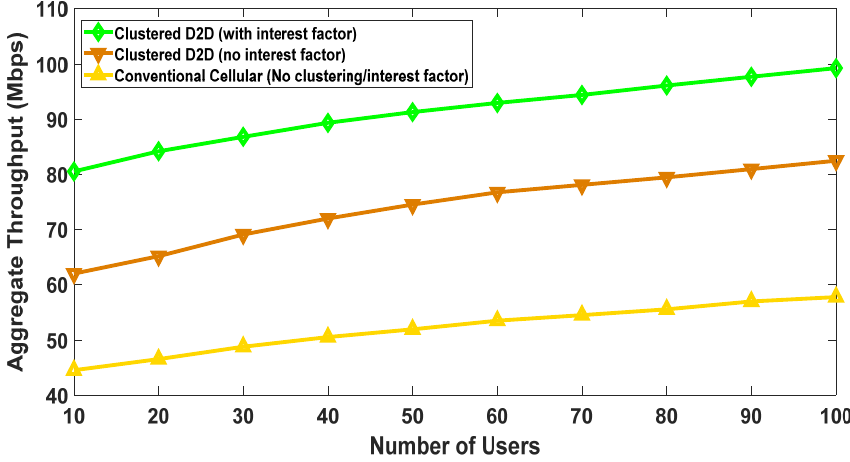
Figure 8. The impact of clustering and social ‐ interest on throughput.